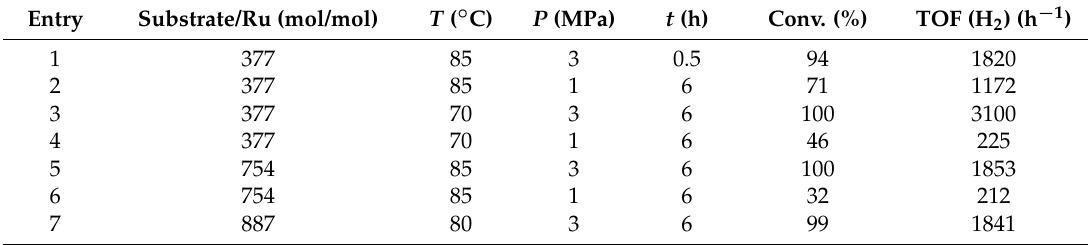
Table 2. Hydrogenation of phenol in water in the presence of G3-dendr-SiO 2 -Ru catalyst 1